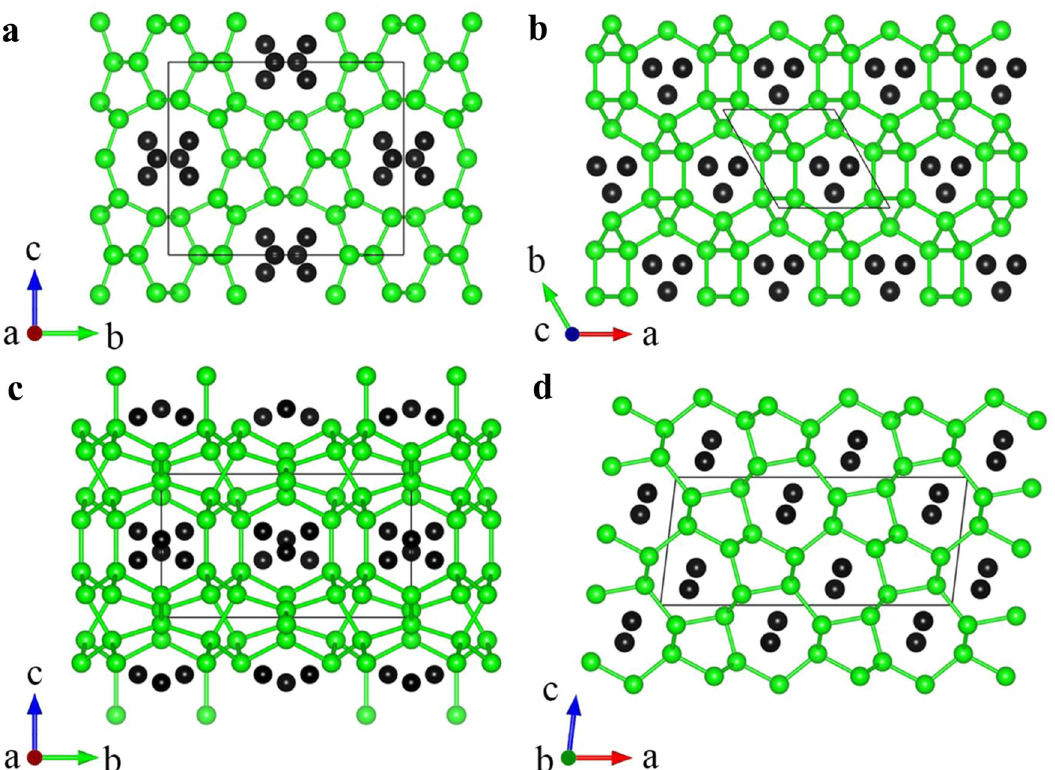
Fig. 2 Structural con fi gurations of the predicted Si 2 He phases. Crystal structures of a oP36-Si 2 He, b tP9-Si 2 He, c mC18-Si 2 He, and d mC12- Si 2 He at 10 GPa. Black and green spheres represent He and Si atoms,